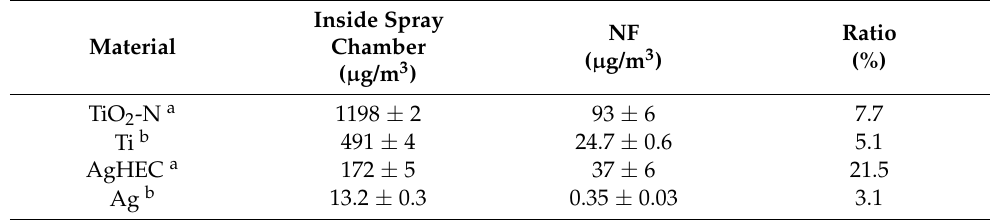
Table 1. Aerosol mass concentrations obtained by gravimetric measurement, and ICP-OES mass analysis.